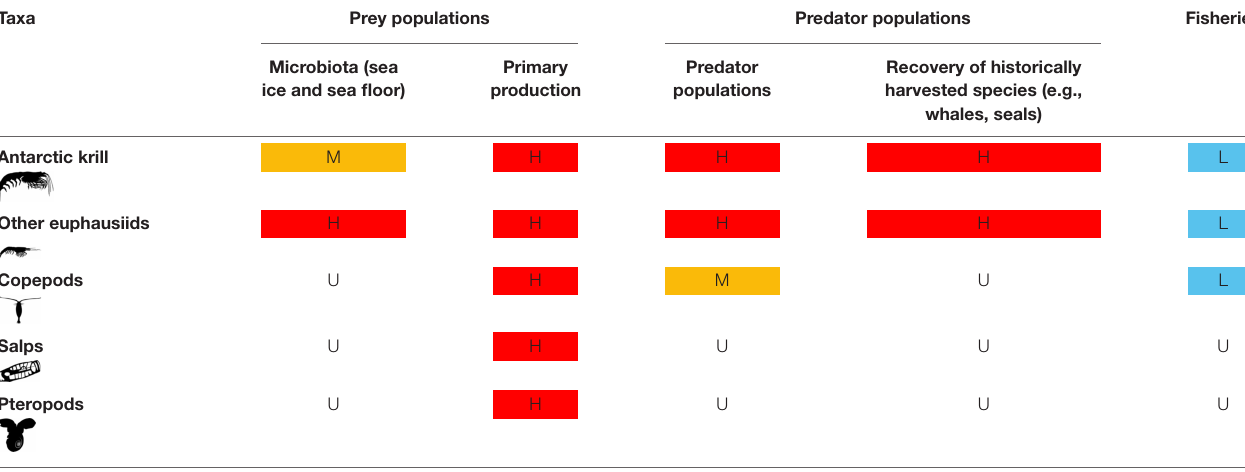
TABLE 2 | Assessment* of the potential impacts of key ecological drivers of change on the distribution and abundance of key Southern Ocean zooplankton taxa (based in information in Sections “Euphausiids (Family Euphausiidae), Copepods (Subclass Copepoda), Salps (Order Salpida), Pteropods (Order Pteropoda), and Past Changes in Zooplankton: A Modelled Example Using Continuous Plankton Recorder Data”, including references cited therein). See Supplementary Table 3 for a more detailed assessment of the potential future changes in these taxa (in response to some of these drivers) and their potential capacity for